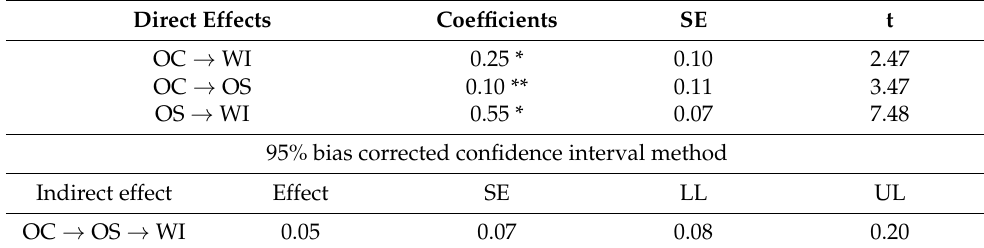
Table 5. Bootstrapping results for direct and indirect